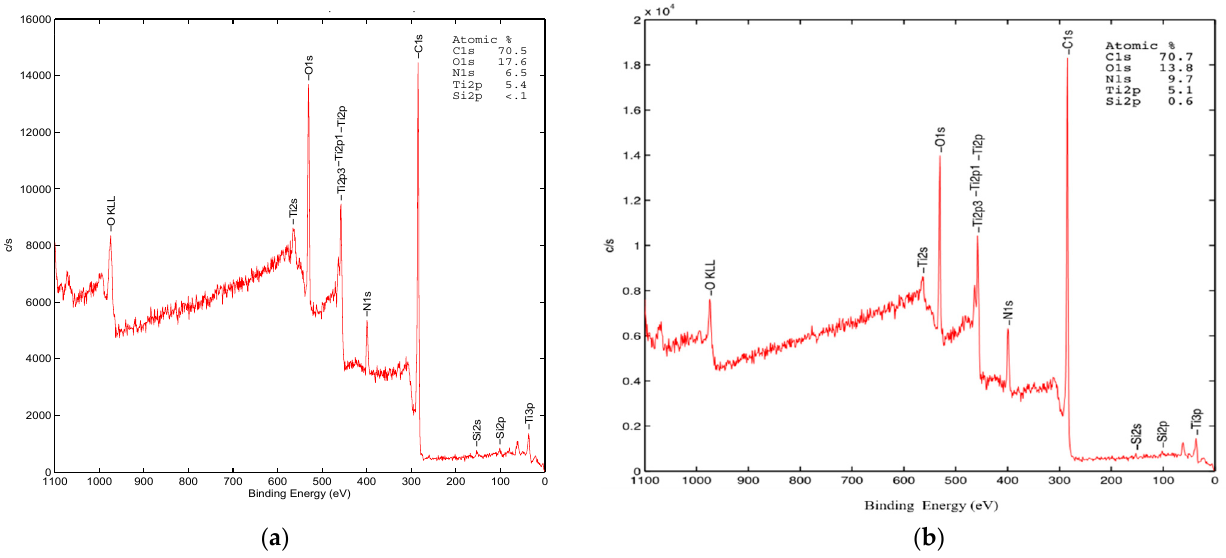
Figure 8. XPS spectrum for recipe ( a ) medium as-spun fiber and ( b ) after calcined at 230 °C for an hour.